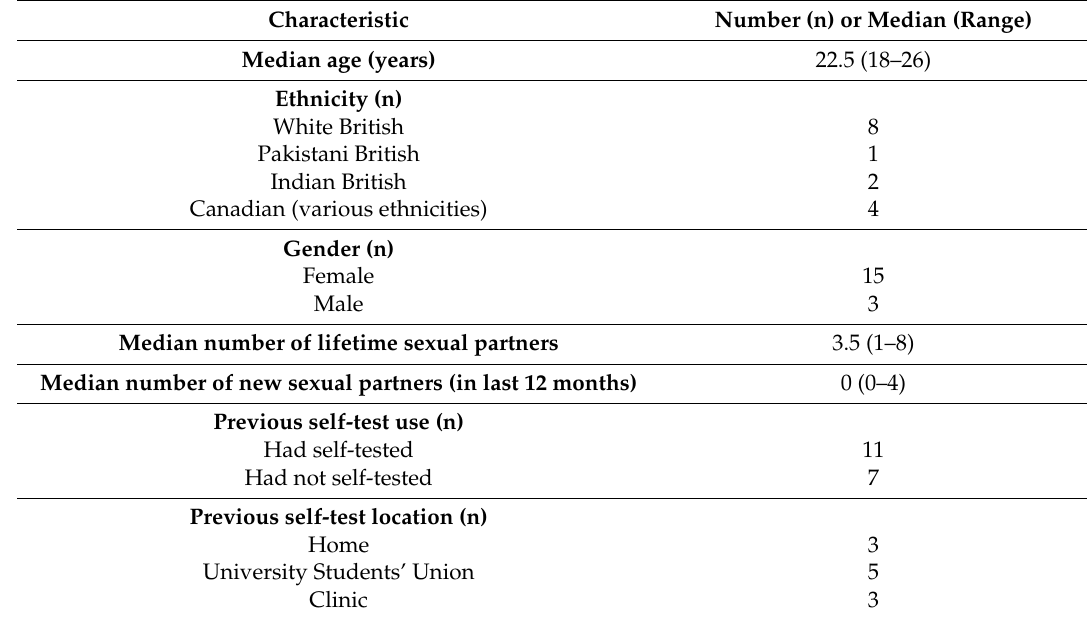
Table 1. Description of